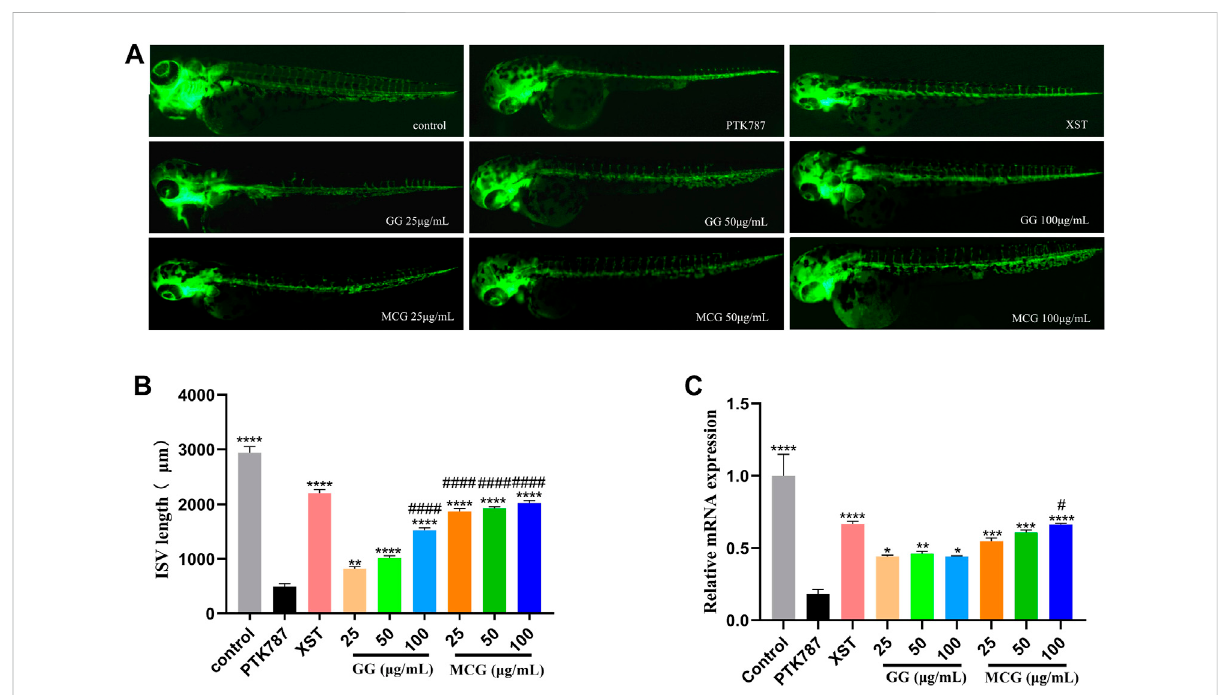
FIGURE 5 Effect of MCG and GG on intersegmental vessel (ISV)growth in zebra fi sh. The embryos at 21 hpf were pretreated with 0.2 μ g/ml PTK787 (VEGF receptorinhibitor)for3handthentreatedwithvariousconcentrationsofMCGandGG(25,50,100 μ g/ml)for48h. (A) ISVgrowthafterMCGandGG treatmentinzebra fi sh. (B) ISVlengthwascalculatedinzebra fi shembryos. (C) ThemRNAexpressionofVEGFR2wasanalyzedusingRT-PCR.Dataare represented as the mean ± standard error of the mean. n = 3. * p < 0.05, ** p < 0.01, *** p < 0.001, **** p < 0.0001 versus the PTK787 group; # p < 0.05, #### p < 0.0001 compared with the GG (25 μ g/ml)-treated